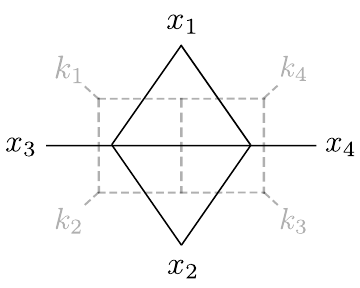
Figure 6 . Leading contribution to the four-point functions (B.7) in position-space variables (solid) and dualised momenta